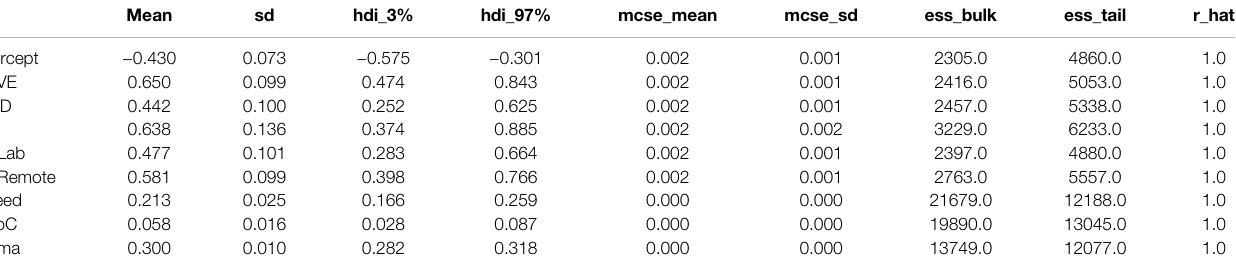
TABLE 3| SummaryforCITmodel: CIT ∼ Condition + Speed + GapC +(1| ID ).REALserved asabaseline.GapCreferstothecenteredgapsizevariable[ − 2s,2s]rather than [1s, 5s]. Mean